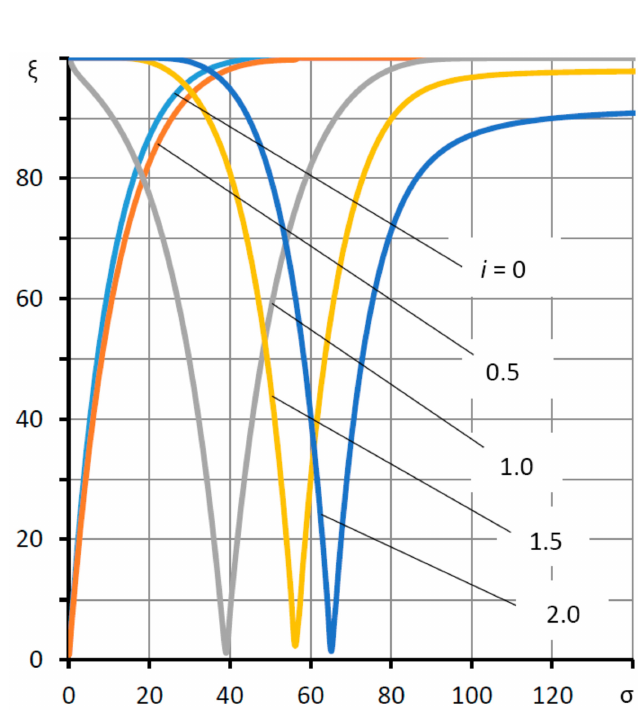
Figure 8. Dependences of the oscillation damping criterion for the period ξ on the “compression number” σ for different values of the elasticity coefficient K e = i K e 0